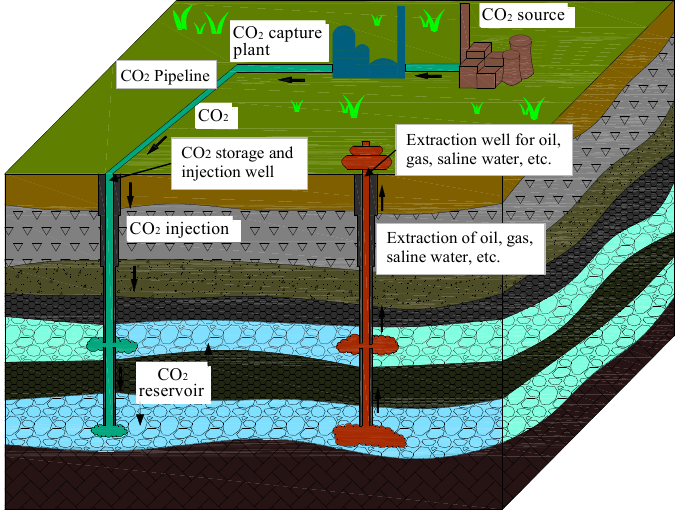
Figure 1. Overall schematic of carbon capture and storage concept.